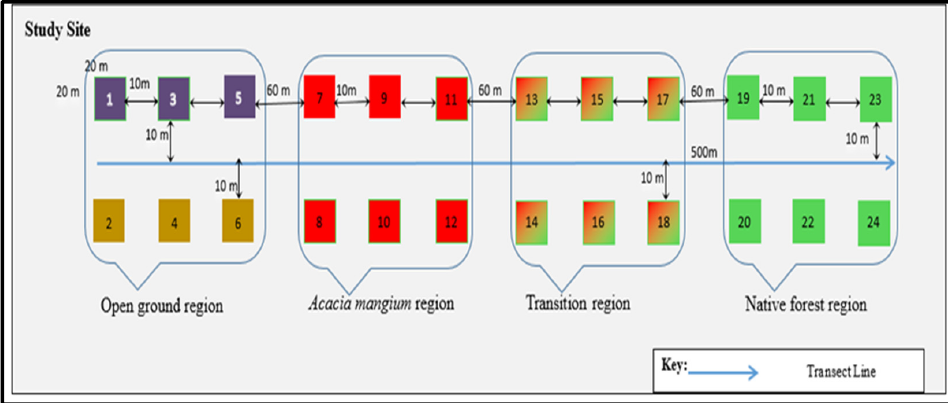
Figure 4. Schematic diagram of plot placement in this study.